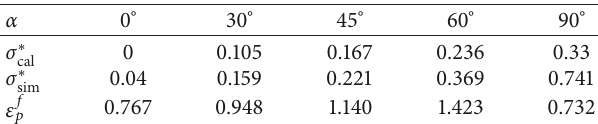
Table 7: The calculated and actual initial stress triaxialities and corresponding fracture strains.